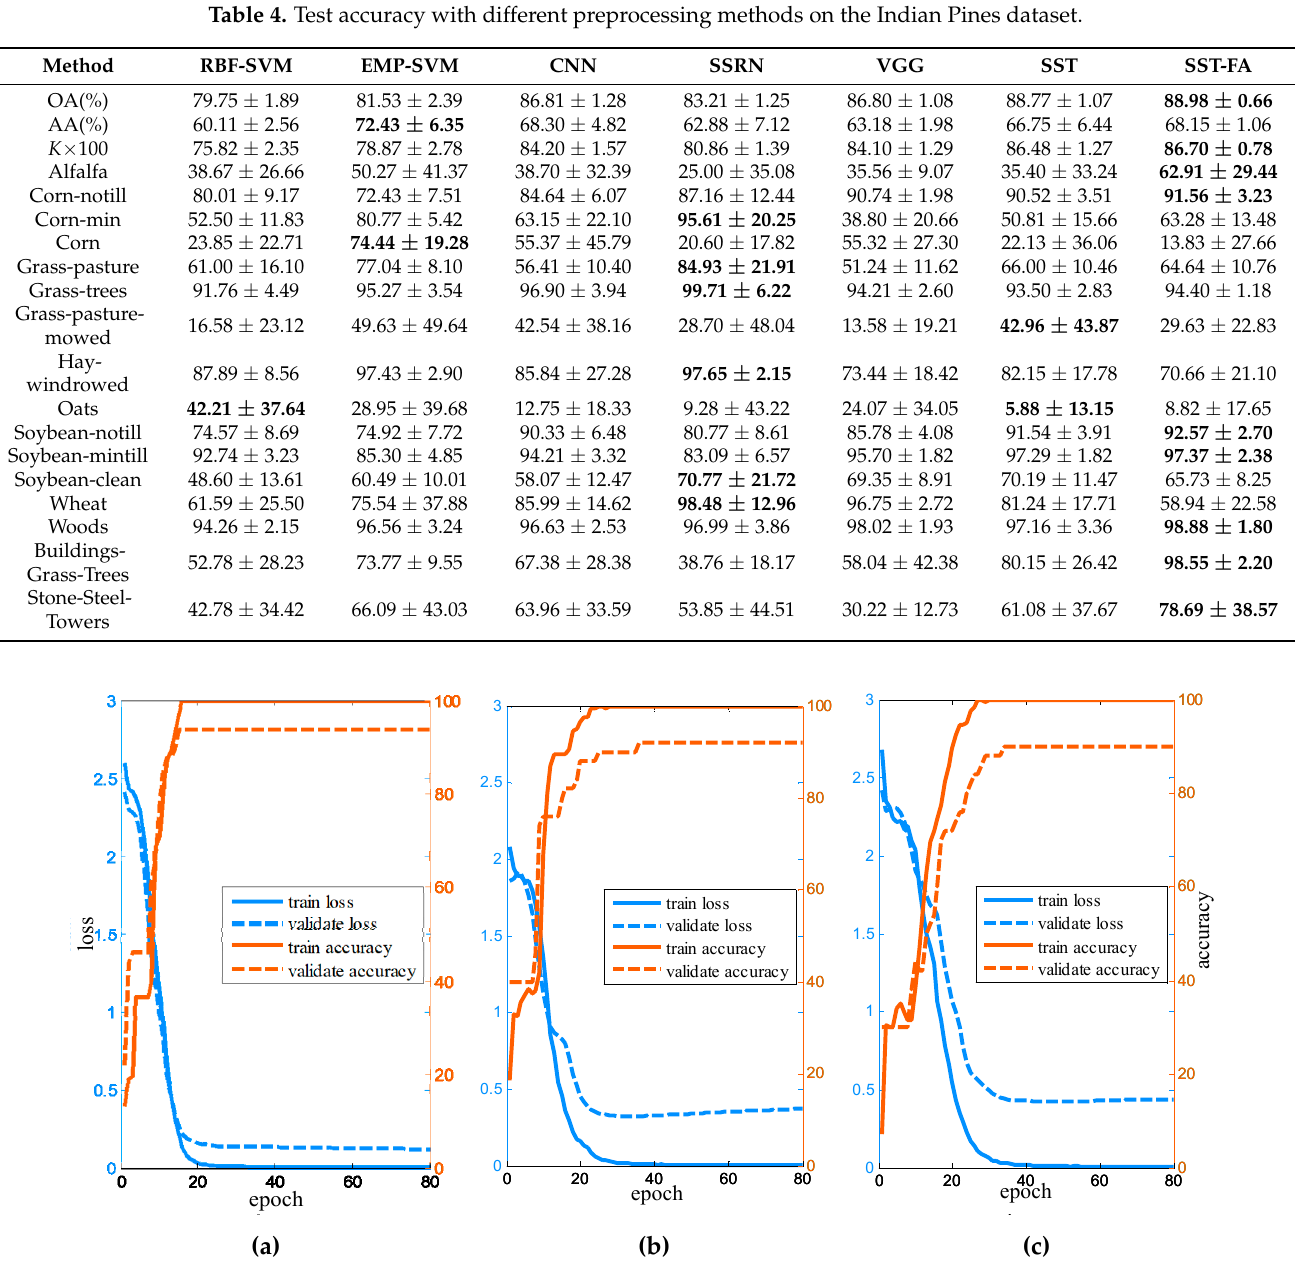
Figure 9. Learning curves of SST on the three HSI datasets. ( a ) Salinas; ( b ) Pavia; ( c ) Indian Pines.